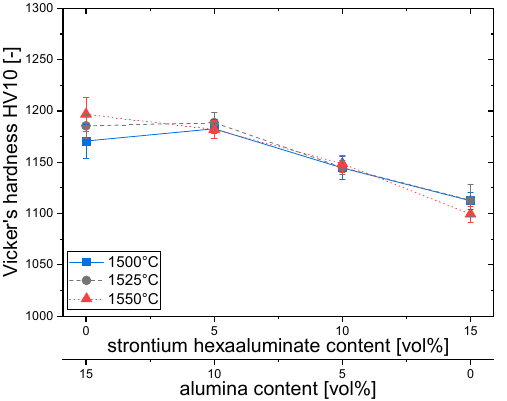
Figure 3. Vickers hardness HV10 depending on composition and sintering temperature.